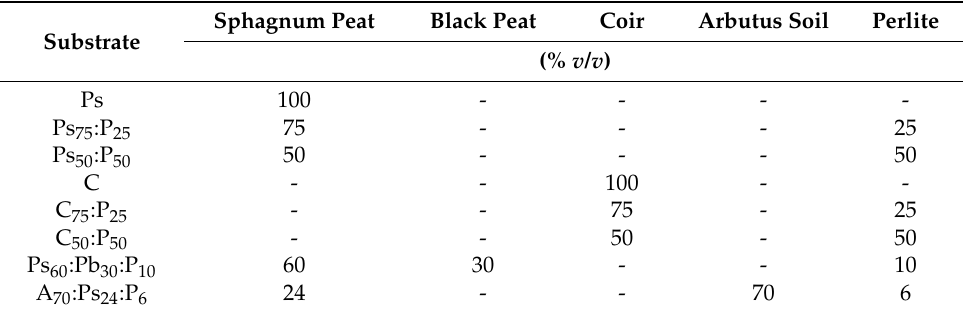
Table 1. Composition on a volume basis of peat- and coir-based substrates used.